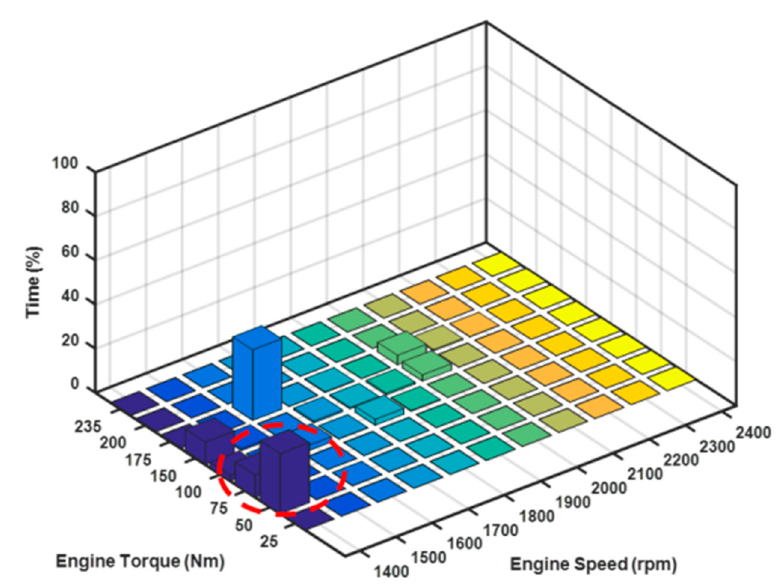
Figure 16. Engine operating time in urban driving cycle with ECMS optimization.